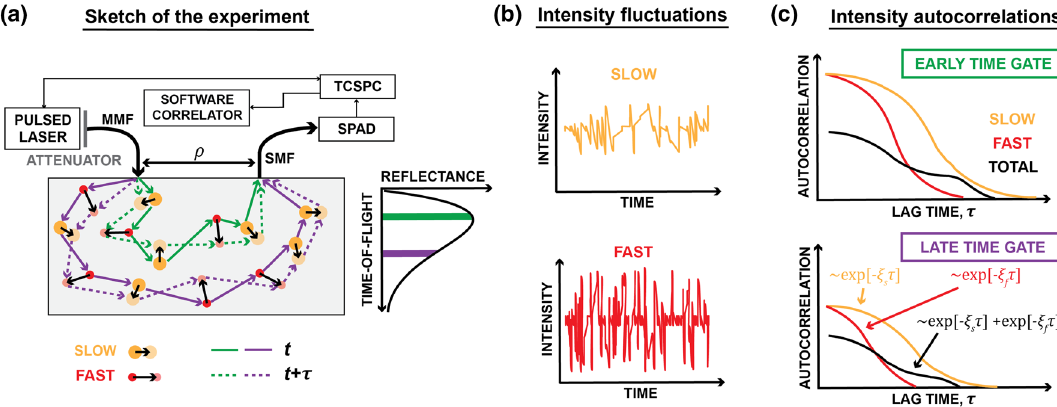
Figure 1. Time-domain diffuse correlation spectroscopy in samples composed of particles moving at different speeds. ( a ) The light emerging from the source is multiply scattered from slowly (orange), and rapidly